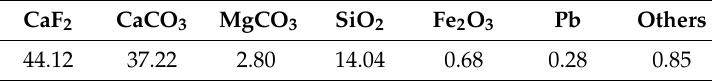
Table 2. Chemical analysis of the mineral (mass fraction,